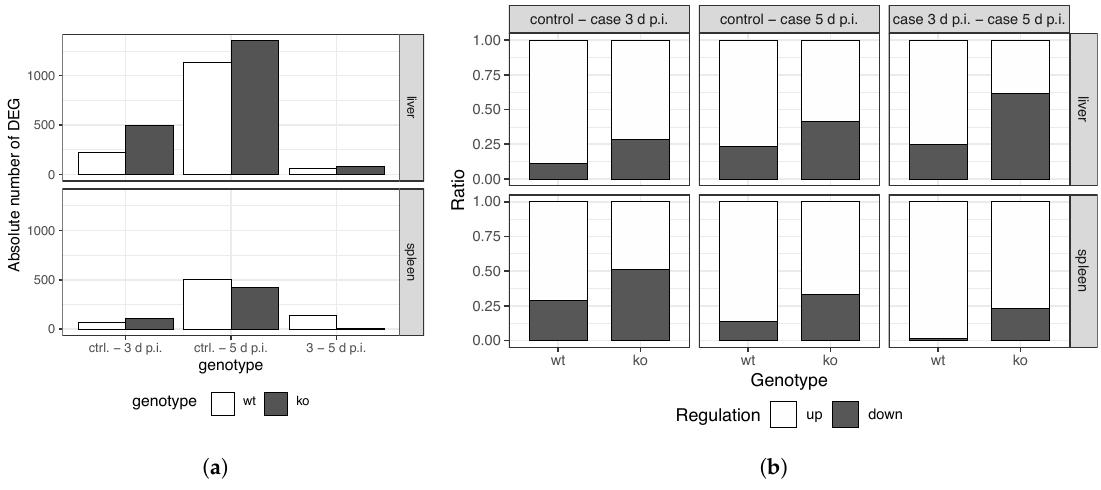
Figure 3. ( a ) Absolute numbers of DEG in the different comparisons ( b ) Ratio of up- and downregulated DEG in the different performed comparisons. Three comparisons were performed: control vs. case samples at 3 d p.i., control vs. case samples at 5 d p.i. and case samples at 3 vs. 5 d p.i. ko refers to Ly6E ∆ HSC